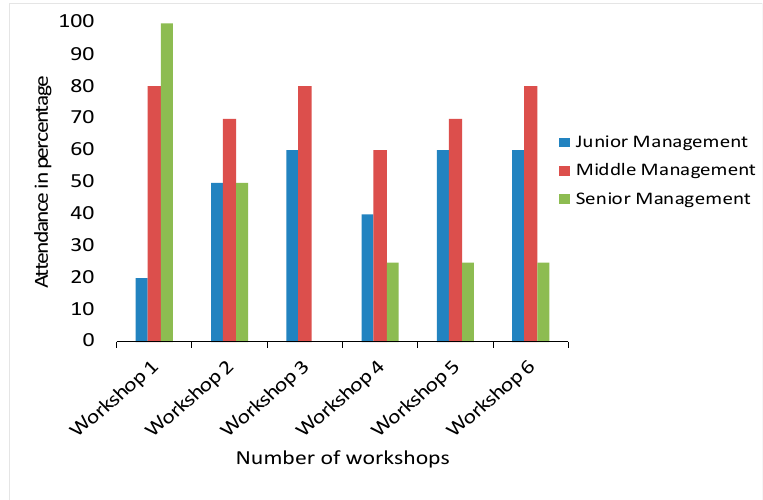
Figure 4. Changes in the frequency of attendance by government actors over time.